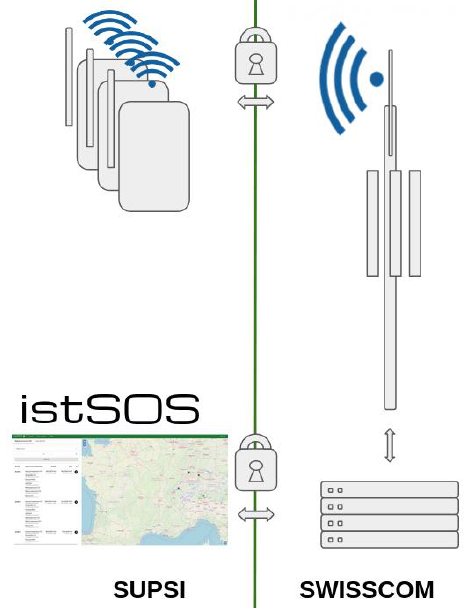
Figure 2. The LoRaWAN package transmission